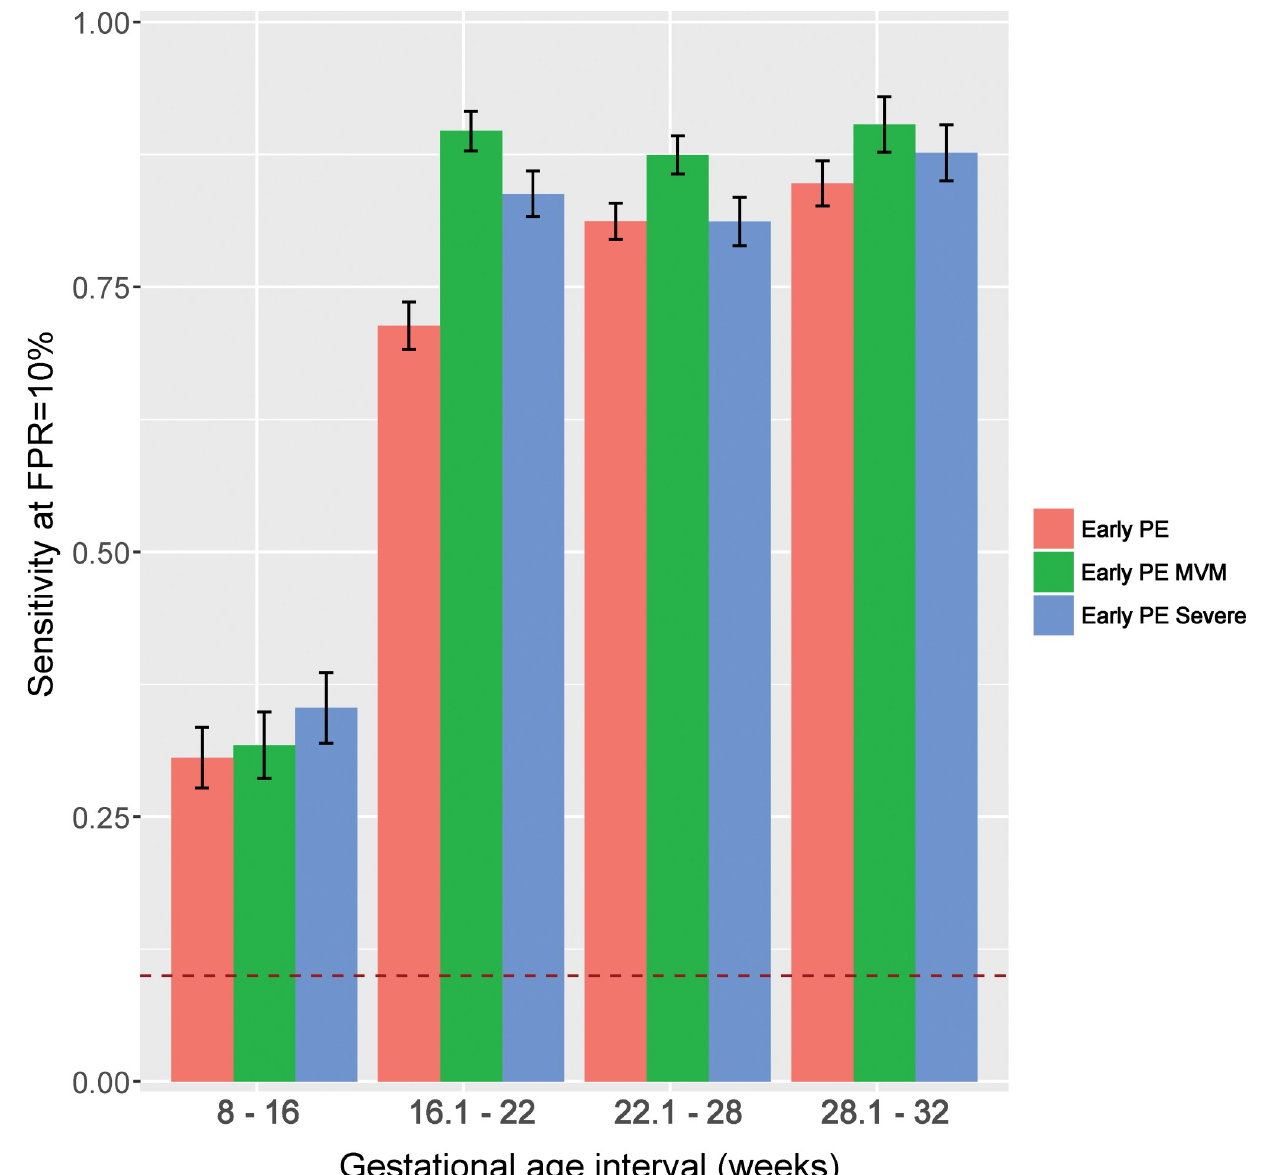
Fig 1. Sensitivity for early preeclampsia using multi-protein markers. Sensitivity (y-axis) at a 10% FPR are shown by gestational-age interval (x-axis) for early preeclampsia (PE), early PE with placental lesions consistent with MVM, and severe early PE. The vertical bars represent the average (with 95% confidence intervals) of sensitivity obtained from 200 bootstrap iterations. Early PE: early preeclampsia; FPR: false-positive rate; MVM: maternal vascular malperfusion.